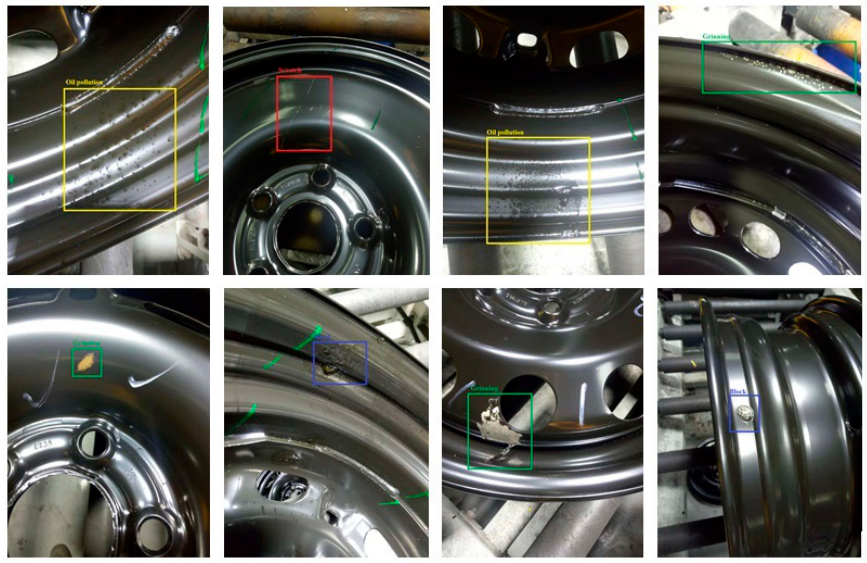
Figure 4. Images with bounding boxes and labels.